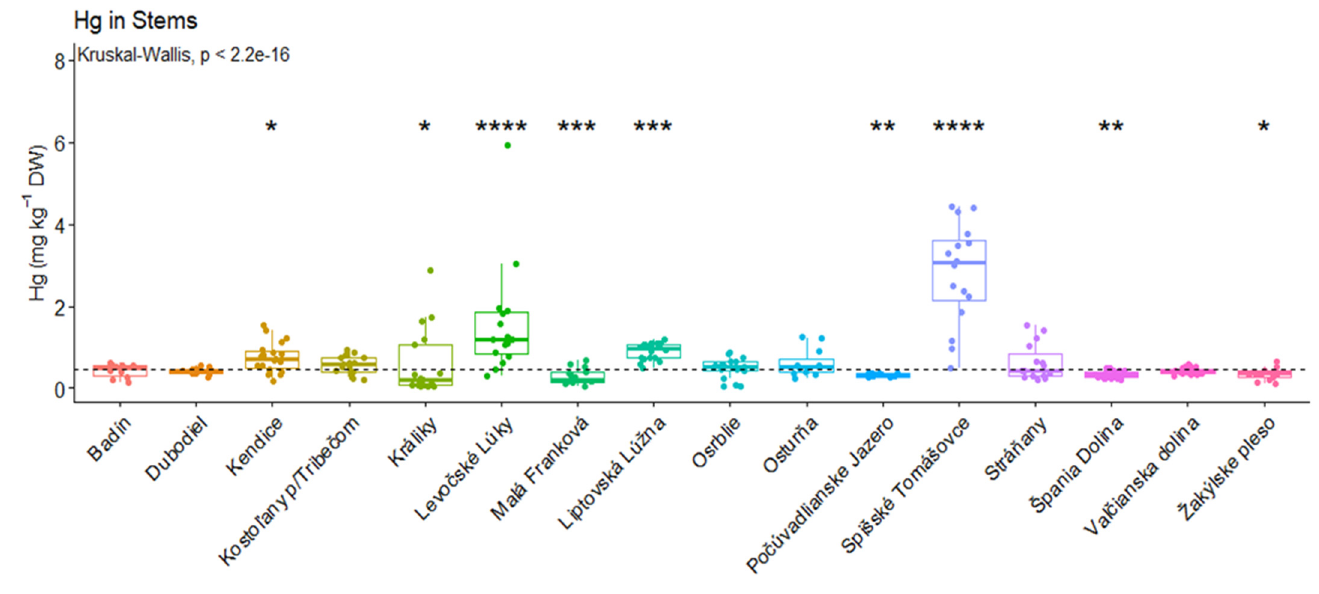
Figure 4. Significant differences in mercury concentrations (stems) in mg kg − 1 , (* p < 0.05; ** p < 0.01; *** p < 0.001; **** p < 0.0001).